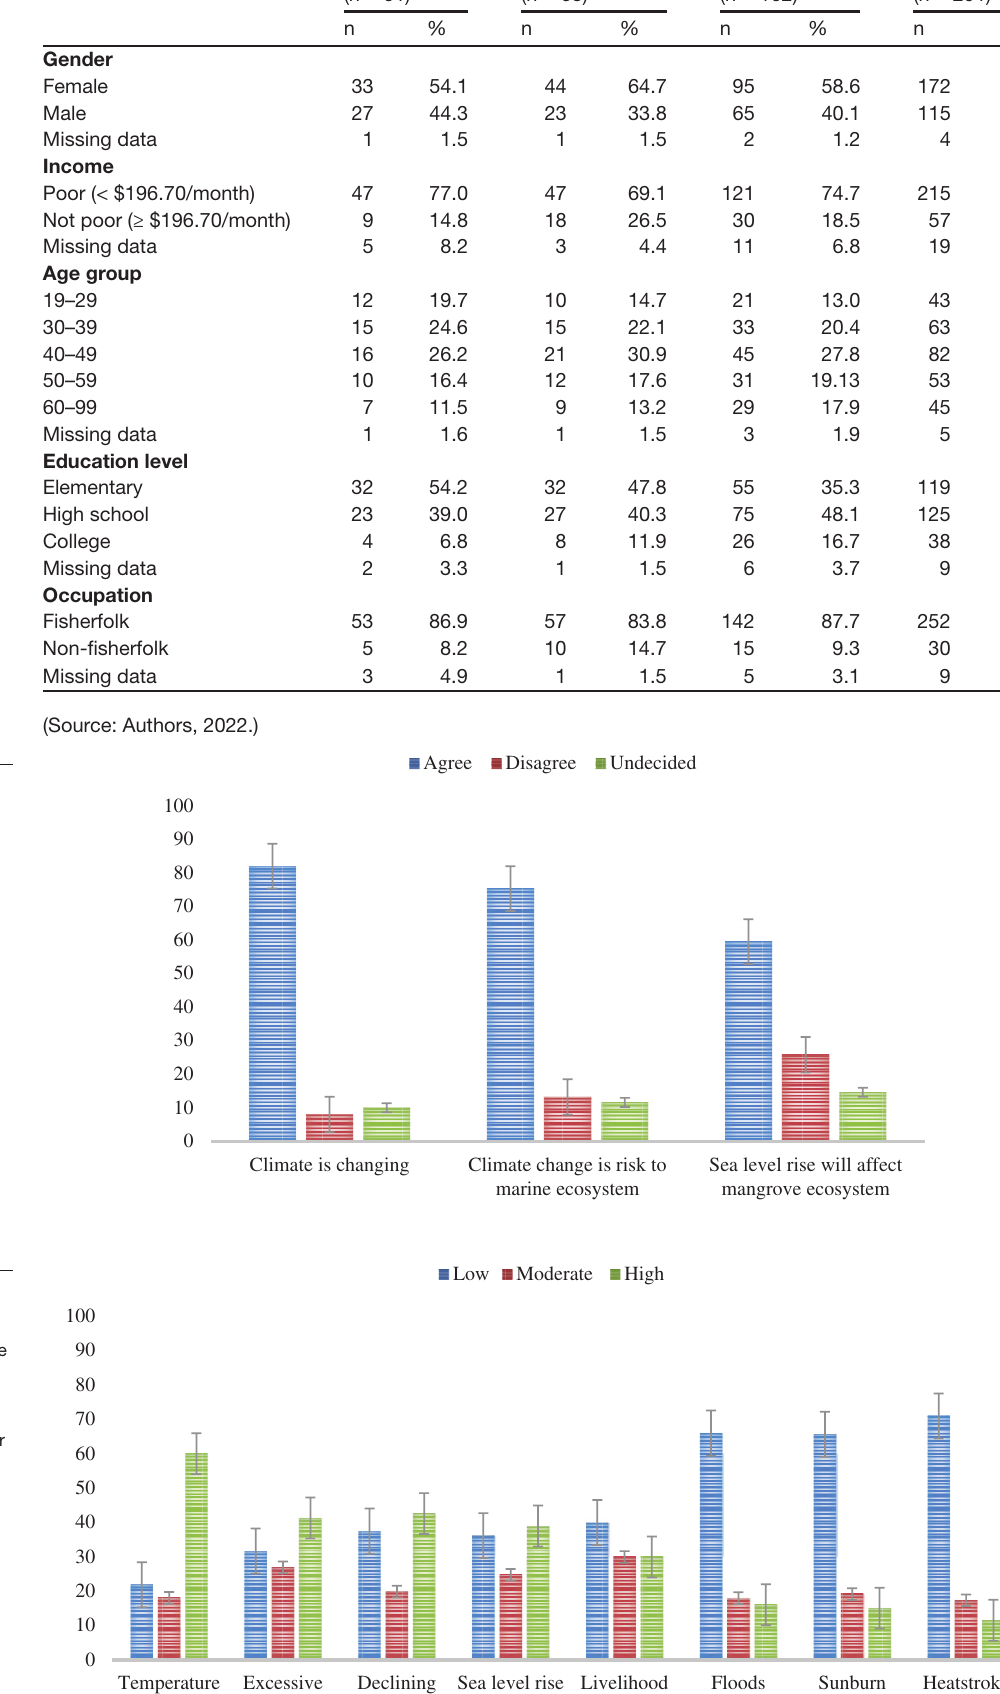
Table 1. Socio-demographic characteristics of the respondents (n = 291) Category